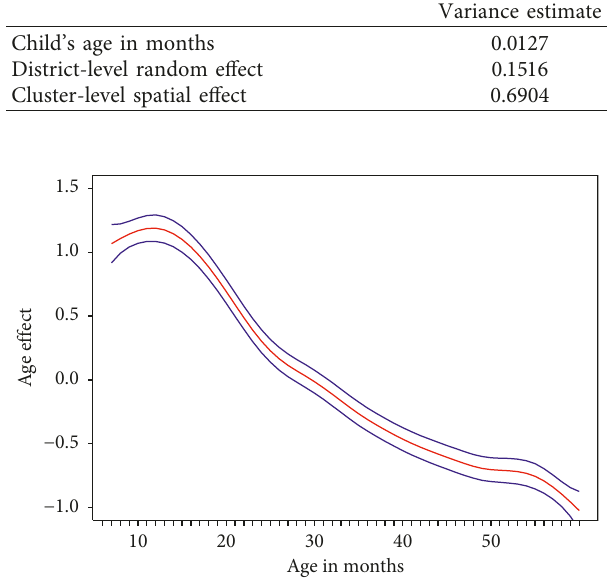
Figure 3: Estimated nonlinear effect of the child’s age in months on the log-odds of anaemia together with the 95% confidence interval.